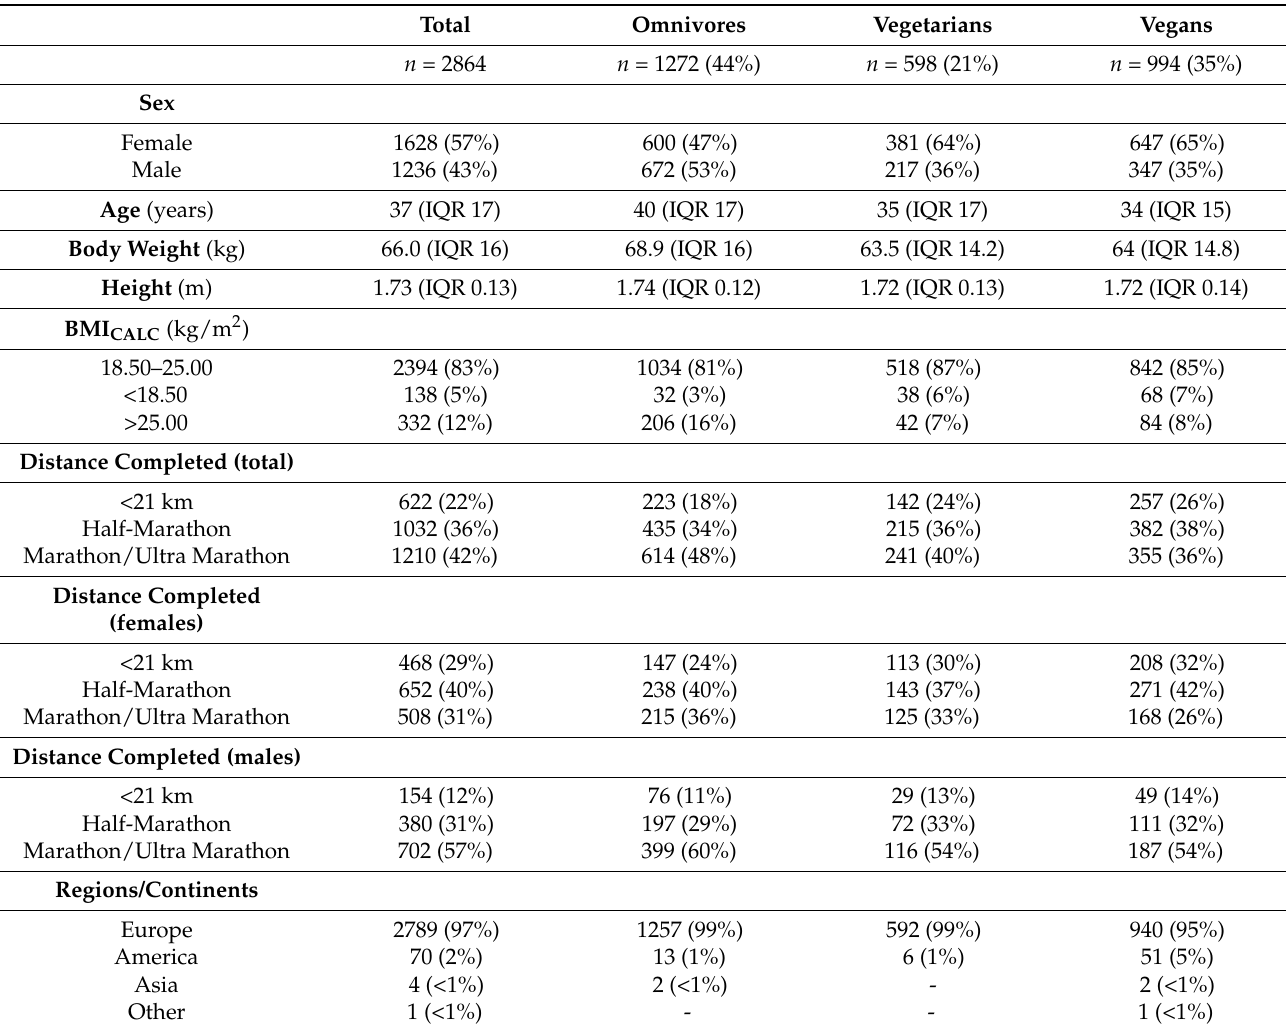
Table 1. Sociodemographic characteristics of participants displayed by dietary subgroups. Total Omnivores Vegetarians